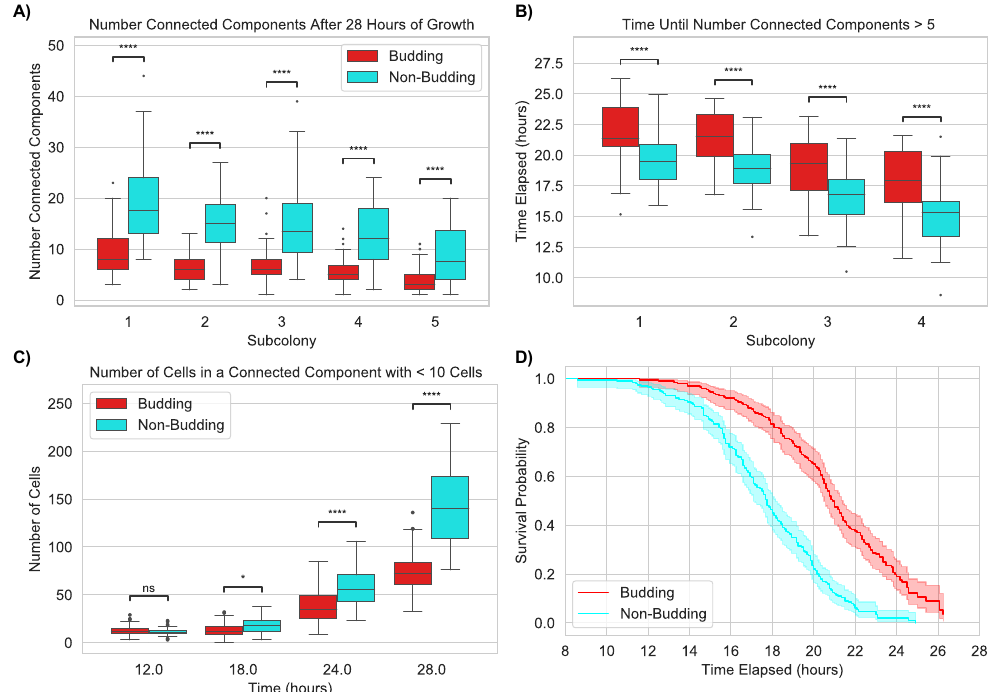
Figure 10. Subcolony Structure and Organization in Nutrient-Limited Colonies. ( A ) Comparison of the number of connected components for the first five subcolonies between budding (red) and non-budding (blue) colonies at the 28 h time point. We observe a statistically significant difference in the number of connected components for subcolony 1 ( p = 3.39 × 10 − 10 ), subcolony 2 ( p = 4.454 × 10 − 17 ), subcolony 3 ( p = 8.537 × 10 − 11 ), subcolony 4 ( p = 2.884 × 10 − 11 ) and subcolony 5 ( p = 3.783 × 10 − 06 ). ( B ) Comparison of time until each of the first five subcolonies splits into 5 connected components. We observe a statistically significant difference between budding (red) and non-budding (blue) colonies for subcolony 1 ( p = 8.967 × 10 − 05 ), subcolony 2 ( p = 6.246 × 10 − 08 ), subcolony 3 ( p = 8.636 × 10 − 05 ), and subcolony 4 ( p = 9.154 × 10 − 06 ). ( C ) Comparison of the number of cells in a connected component with less than 10 cells. Note that nutrient-limited growth results in a large decrease in the total number of cells in small components at the 24 h time point compared to nutrient-rich growth. However, we still observe a statistically significant difference between budding (red) and non-budding (blue) colonies at 18 h ( p = 3.537 × 10 − 02 ), 24 h ( p = 9.040 × 10 − 07 ), and 28 h ( p = 5.410 × 10 − 18 ). ( D ) Kaplan-Meier survival curves for the length of time a subcolony is made up of less than 5 connected components for budding (red) and non-budding (blue) colonies. The y -axis is the probability that a subcolony consists of less than 5 connected components for longer than t hours, where time is on the x -axis. We observed that the survival curves are different between the budding and non-budding colonies ( p = 2.428 × 10 − 23 ) indicating that the probability that a given subcolony remains connected (i.e., less than 5 connected components) for longer than t hours is greater for budding colonies. (The p -value comparing survival curves was calculated using a log-rank test as described in Section 4.3. In addition, 95% confidence intervals for the survival function are shown. See Section 2.2.4 for